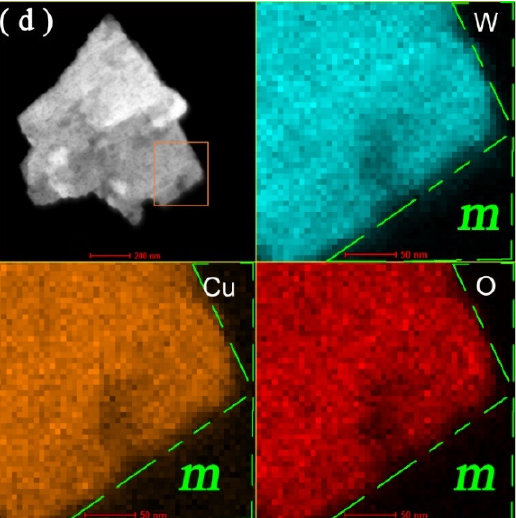
Figure 4. TEM images of WO 3 ( a ), Cu 2 O/WO 3 ( b ) and Cu/Cu 2 O/WO 3 ( c ), inset: HRTEM images), and elemental mapping images of Cu/Cu 2 O/WO 3 ( d ).